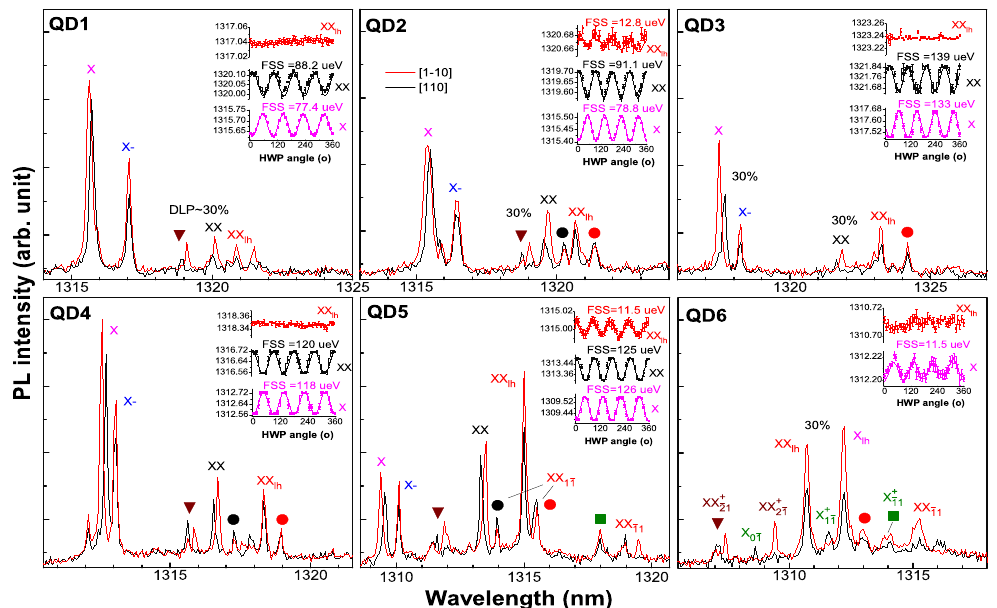
Figure 3. Polarization-resolved µ PL spectra of QD1–6 with large FSS, black and red: orthogonal axes [110] and [1–10], large DLP ~30% marked. ( Insets ): FSS oscillations. HH excitons X and XX in large FSS and opposite signs; LH excitons marked, especially XX lh with small FSS, inverted triangle: XX 21+ , circles: XX 1 ¯ı for both HH and LH, square: X¯ı 1+ , QD6: more LH excitons located around XX lh .